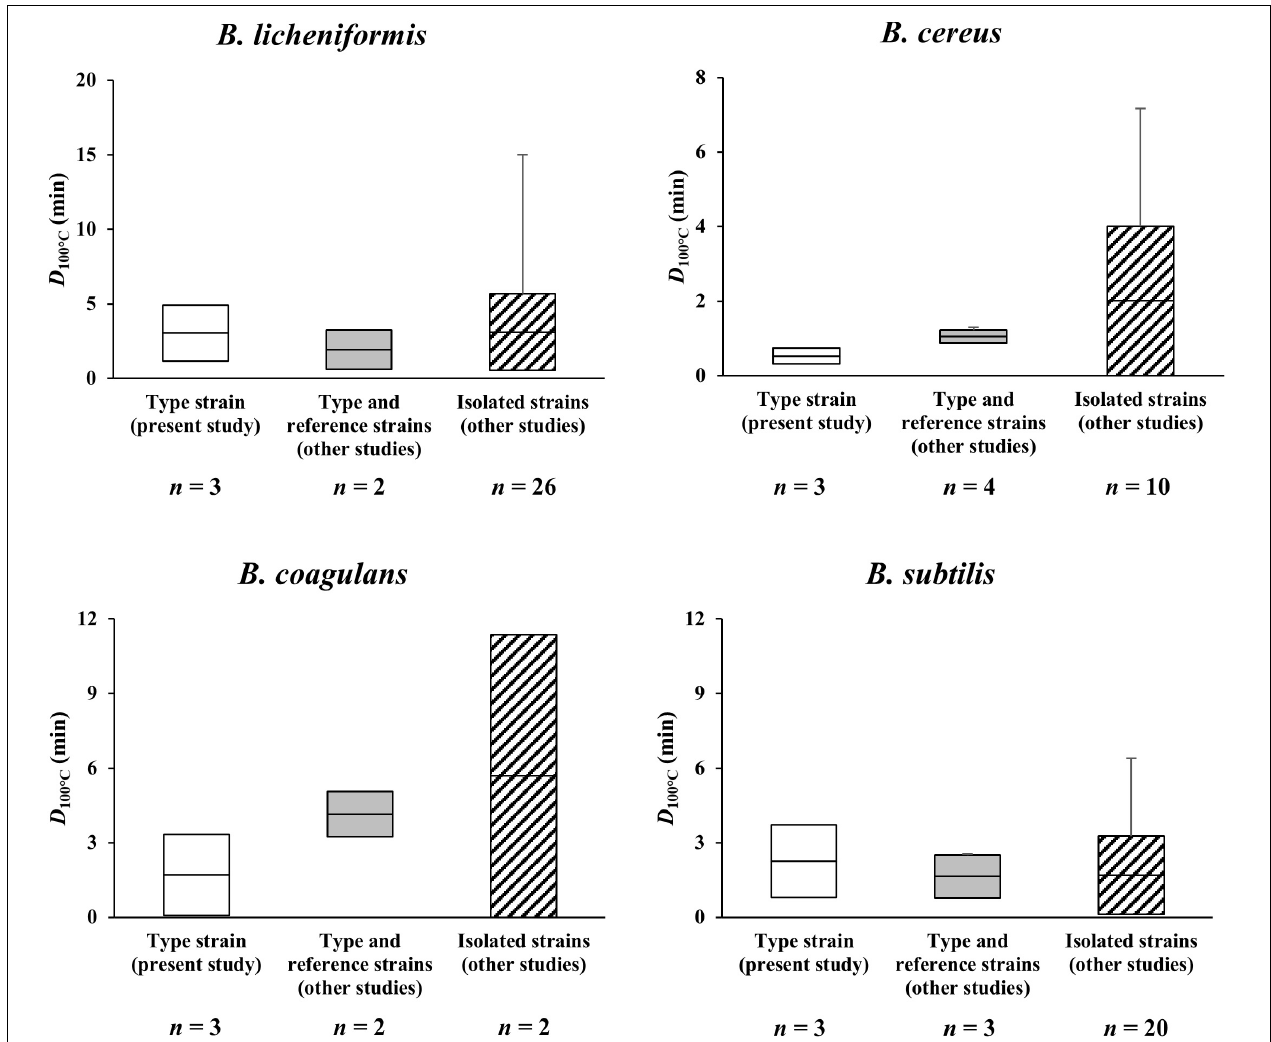
FIGURE 2 | Overview of D 100 ◦ C -values for spores of B. licheniformis , B. cereus , B. coagulans , and B. subtilis formed on basal media without mineral supplementation. The horizontal lines in the boxes indicate mean D 100 ◦ C -values, and the boxes extend to the values of standard deviation after removal of outliers via Q -test. The error bars range from the minimum to the maximum D 100 ◦ C -values. There were no statistical differences ( p > 0.05) between mean D 100 ◦ C -values included in the plot for each Bacillus species. (cid:3) : D 100 ◦ C -values of the spores of type strains of Bacillus species determined in the present study, : D 100 ◦ C -values of the spores of type and reference strains obtained from previous studies, : D 100 ◦ C -values of the spores of isolated Bacillus strains obtained from previous studies. D 100 ◦ C -values of each type strain used in the present study were determined from different spore batches, and D 100 ◦ C -values obtained from previous studies were selected by the criteria described in section “Comparison of Heat Resistance Profiles of Spores of Four Representative Bacillus Species.” n : number of D 100 ◦ C -values (measured independently) present in each